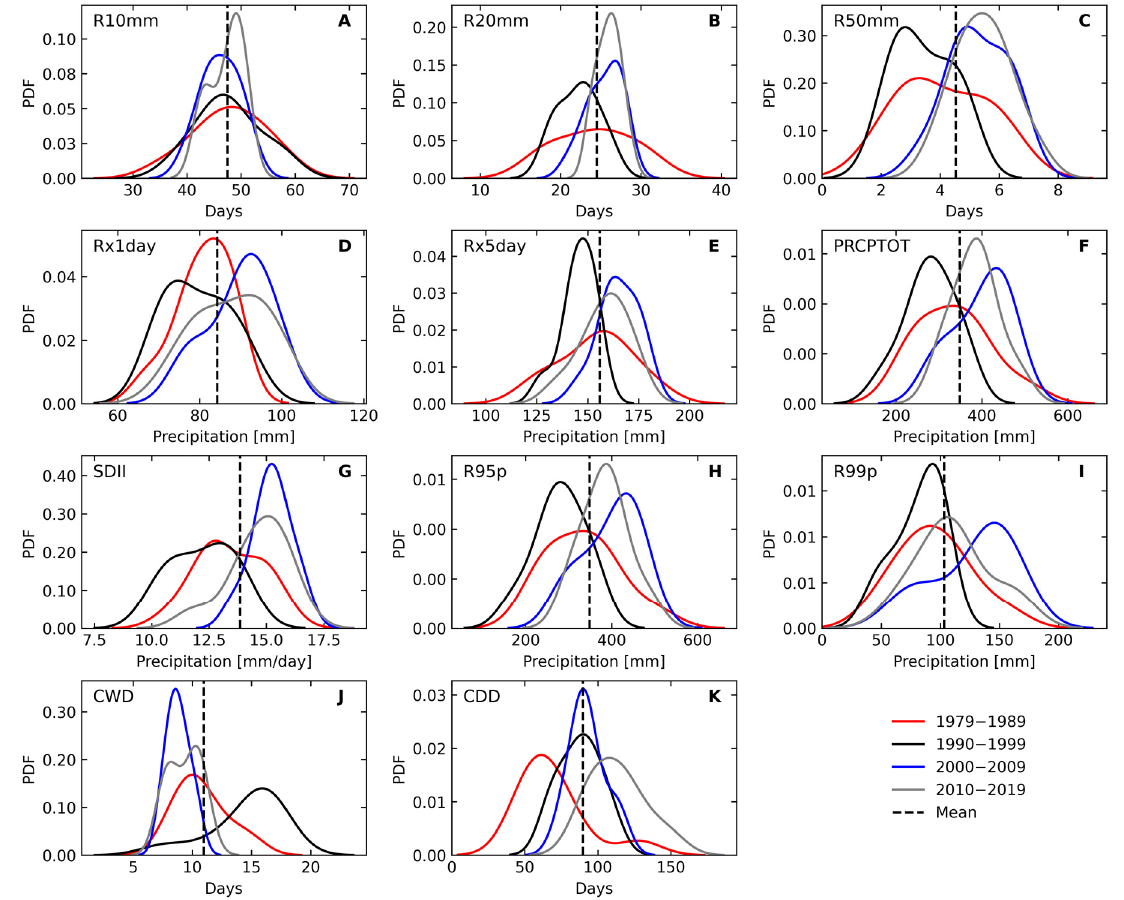
Figure 3. Probability Density Function (PDF) of the annual frequency of the number of heavy precipitation days (R10mm) ( A ), the number of very heavy precipitation days (R20mm) ( B ), the number of days above 50 mm (R50mm) ( C ), the maximum 1-day precipitation amount (Rx1day) ( D ), the maximum 5-day precipitation amount (Rx5day) ( E ), the annual total wet day precipitation (PRCPTOT) ( F ), the Simple Daily Intensity Index (SDII) ( G ), the precipitation on very wet days (R95p) ( H ), the precipitation on extremely wet days (R99p) ( I ), the Consecutive Wet Days (CWD) ( J ), and the Consecutive Dry Days (CDD) ( K ) for the Brazilian Midwest from 1979 to